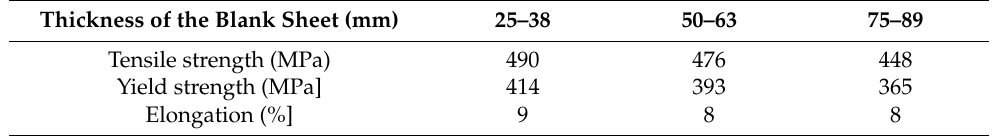
Table 2. Mechanical properties of the 7475-T7351 alloy [4].